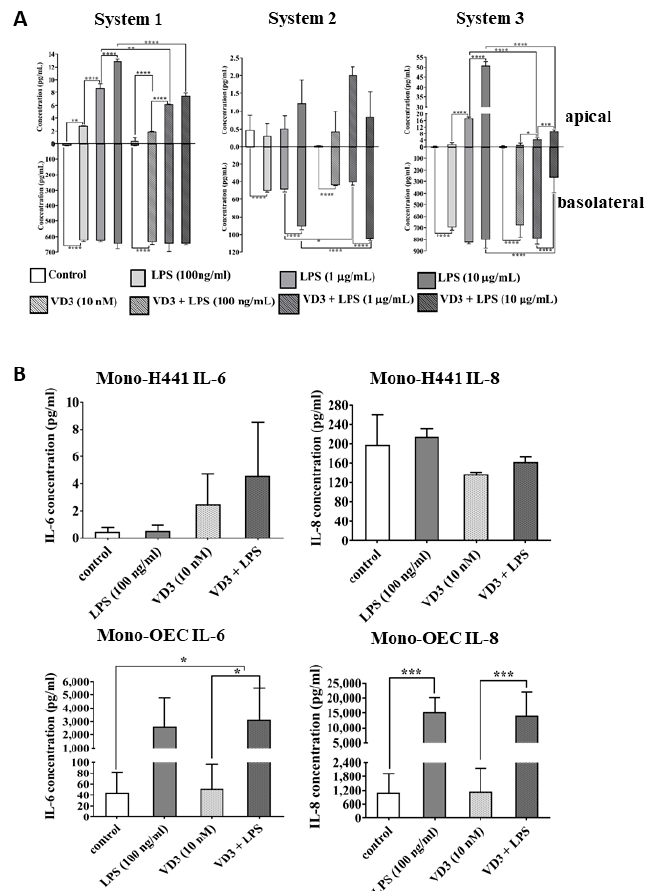
Figure 4. Secretion analyses of pro-inflammatory cytokines from NCI-H441 cells and OECs from different cell culture systems. ( A ) IL-6 secretion from the co-culture of NCI-H441/OECs treated with VD 3 (10 nM) and different doses of LPS (100 ng/mL, 1 µ g/mL, 10 µ g/mL). The supernatants were collected on day 7 from both apical and basolateral compartments of Transwells ® from three individual co-culture experimental sets ( n = 3). ( B ) IL-6 and IL-8 secretions from the mono-culture of NCI-H441 cells and OECs treated with VD 3 (10 nM) and LPS (100 ng/mL). The supernatants were collected on day 7 from the mono-cultures. The values were depicted as pg/mL and shown as mean values ± SD from at least three independent experimental sets ( n ≥ 3). * p < 0.05, ** p < 0.01, *** p < 0.001, **** p < 0.0001, one-way